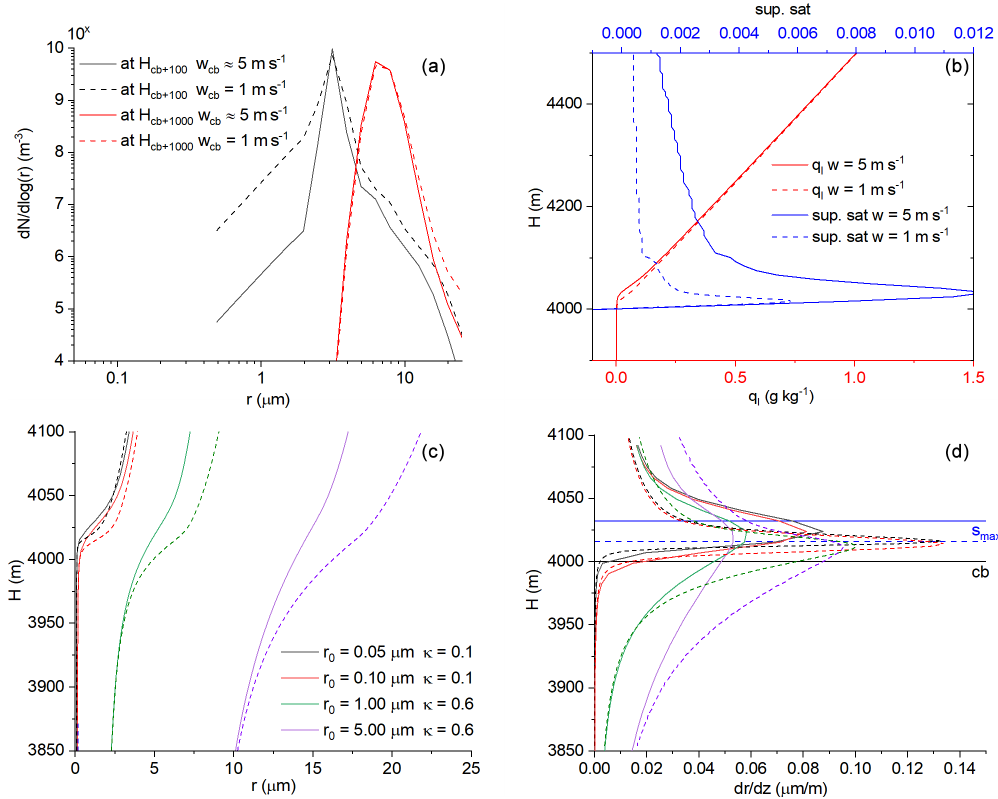
Figure 4. Evolution of (a) DSD, (b) vertical profiles of liquid water content and supersaturation, (c) vertical profiles of the drop radius, and (d) vertical profiles of the vertical gradients of the drop radius. In panels (c) and (d) , the lines with different colors denote different initial aerosol radius and hygroscopicity (see legend in panel c ). The solid and dashed lines denote the cases related to the updraft profiles of strong ( w 1 ) and weak updrafts ( w 3 ) , respectively. The horizontal lines in panel (d) denote the location of the cloud base (black solid line) and that of the maximum of the supersaturation in the case of updraft profiles w 1 (solid blue line) and w 3 (dashed blue line). Note the plots in Fig. 4c start at the altitude of 3800m, and the calculation of the diffusional growth of the water drops starts at 3300m (see Fig.